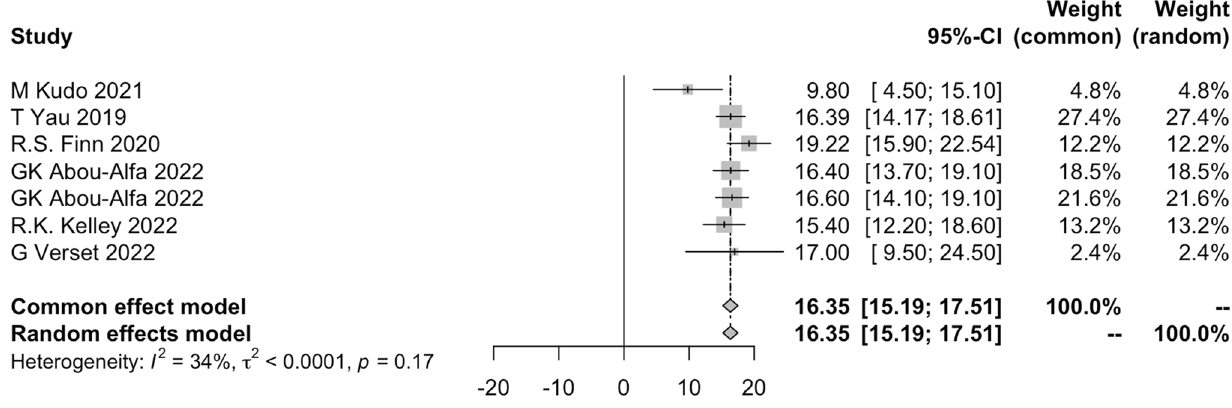
Fig. 5 Pooled results of median